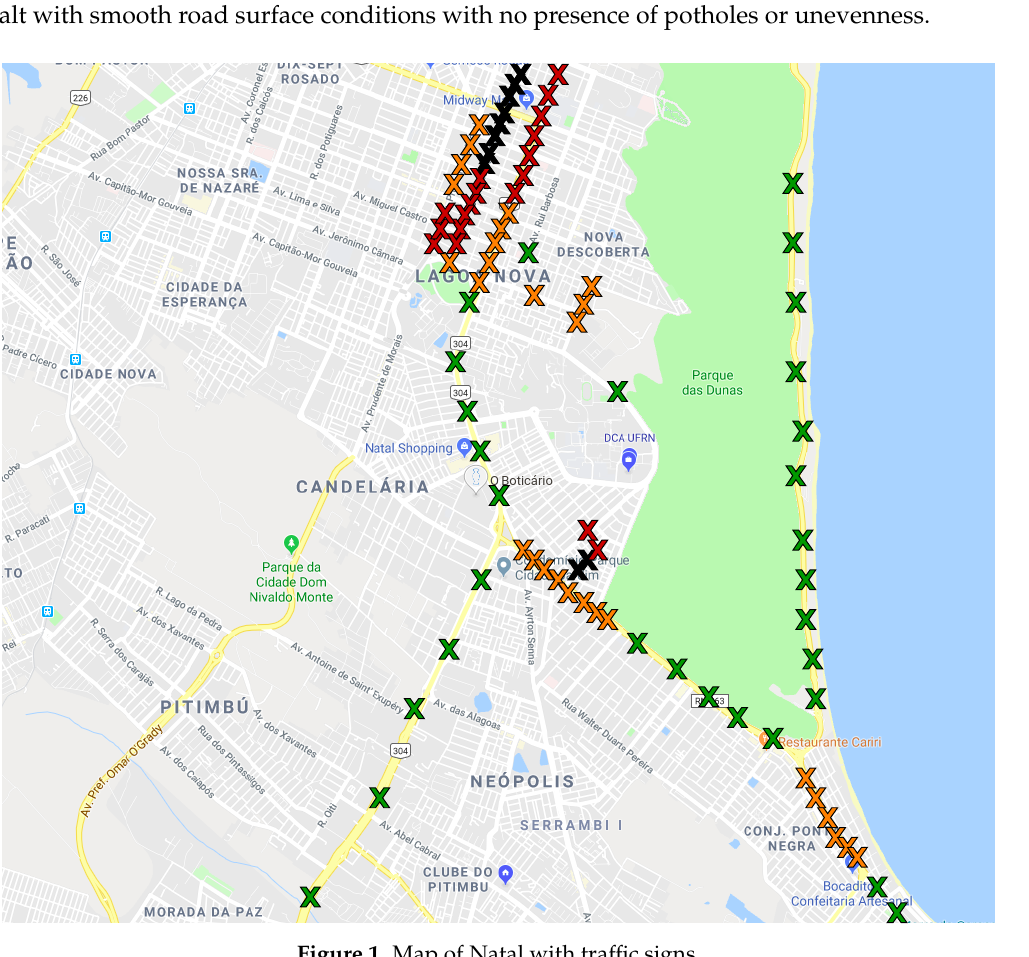
Figure 1. Map of Natal with traffic